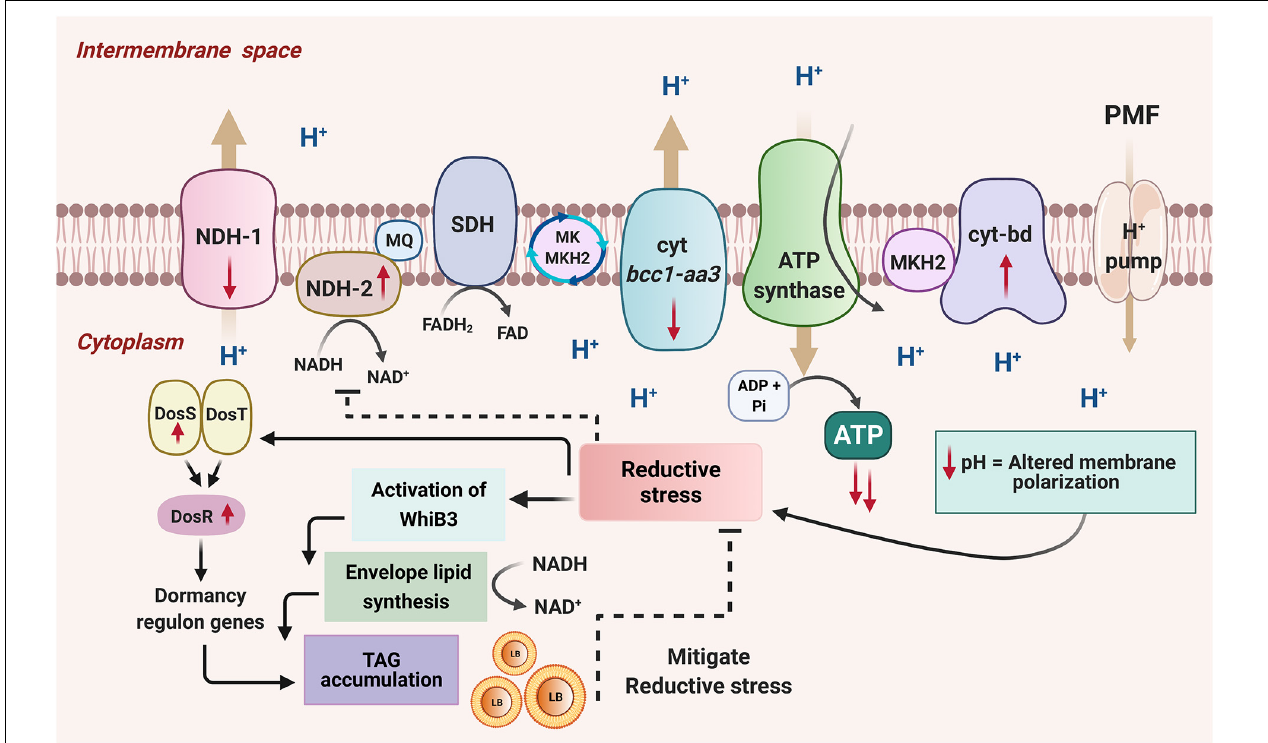
FIGURE 9 | A model depicting the adaptation of M. smegmatis under energy-compromised state. Disruption of one copy of atpD in M. smegmatis drives the transcriptional changes in the mycobacterial ETC. The energy efficient complexes (NDH1 and cyt bc 1 -aa 3 ) are down-regulated while the energy less efficient complexes (NDH2 and cyt bd oxidase) are upregulated as shown by the direction of the red arrows. This leads to the remodeling of the respiration chain, and, as a result, the protons get trapped in the cytoplasmic region as they are now unable to translocate to the periplasmic region, resulting in the decrease in cellular pH. This causes a change in the membrane polarization, and leads to the reductive stress in the cell. This activates a redox sensor, WhiB3, which dissipates the reductive stress by promoting biosynthesis of cell wall associated lipids and by increasing TAG accumulation. WhiB3-mediated lipid biosynthesis helps in the regeneration of NAD + from NADH, which helps in mitigating the reductive stress. The accumulated TAG forms lipid bodies (LB). Mycobacteria also possess another sensing mechanism DosSRT dormancy regulon, which detects changes in cellular redox state through the heme proteins of its two sensor kinases, DosS and DosT. This transfers the signal to the response regulator DosR, which mediates the upregulation of dormancy regulon genes. An essential gene of this regulon that gets activated during stress is the tgs1 , which is the major TAG regulator gene, mediating production and accumulation of lipid bodies (LB) containing TAG, thereby dissipating the reducing equivalents and facilitating mycobacterial survival under energy-compromised state. Hence these combined effects of WhiB3 and Dos regulon mediated signaling pathways function to overcome the energy demand and maintain the redox homeostasis in M. smegmatis under energy-compromised state. Figure is created with